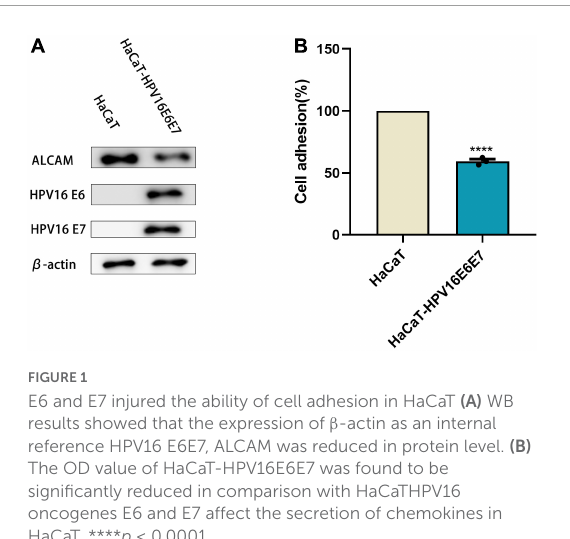
FIGURE1 E6 and E7 injured the ability of cell adhesion in HaCaT (A) WB results showed that the expression of β -actin as an internal reference HPV16 E6E7, ALCAM was reduced in protein level. (B) The OD value of HaCaT-HPV16E6E7 was found to be significantly reduced in comparison with HaCaTHPV16 oncogenes E6 and E7 affect the secretion of chemokines in HaCaT. **** p <